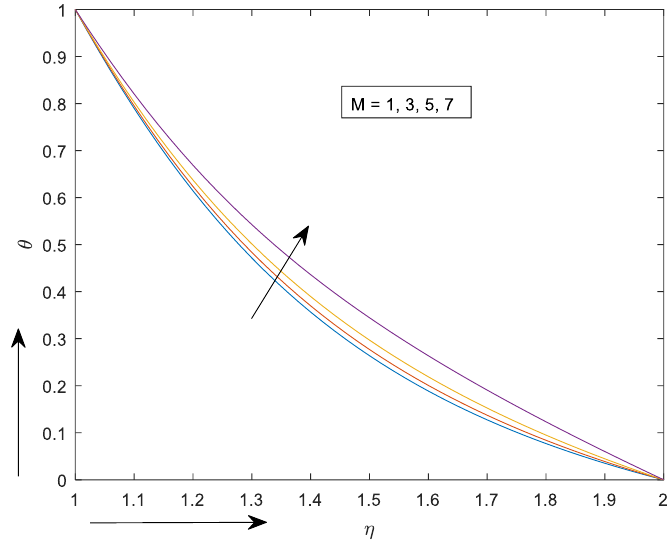
Figure 5. Temperature profile for different values of 𝑀